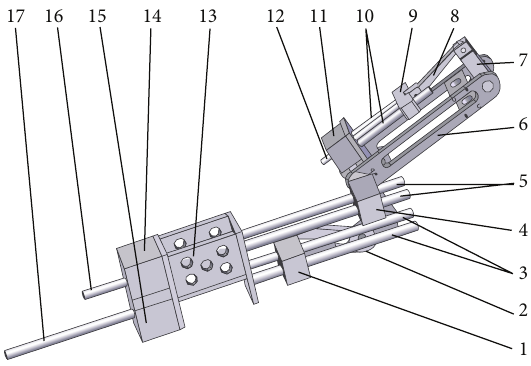
Figure 1: The prototype of 3-DOF forearm.